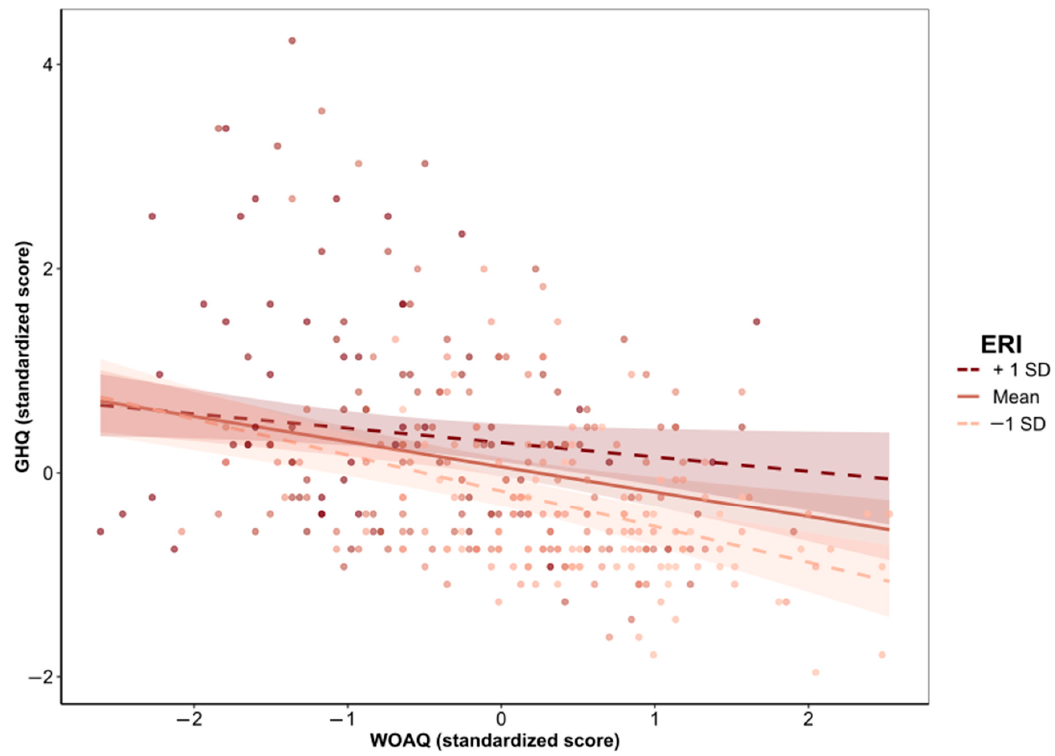
Figure 3. Simple slopes plot of the job strain model.